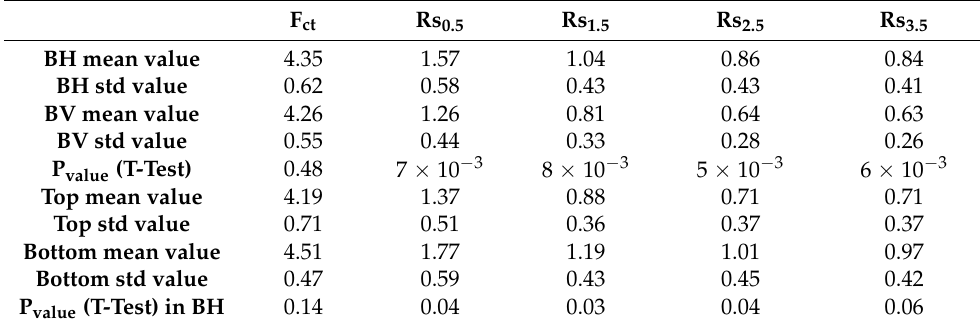
Table 8. P value of a t -test on the effect of pouring procedure on concrete resistance